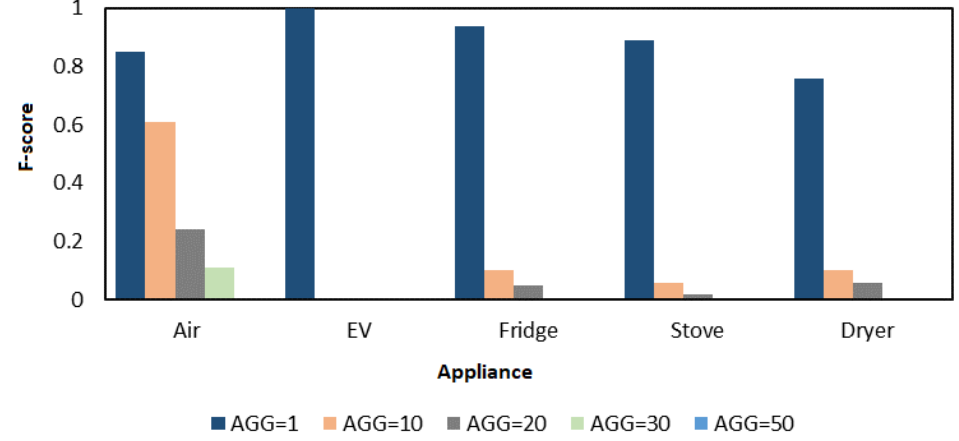
ff erent aggregation